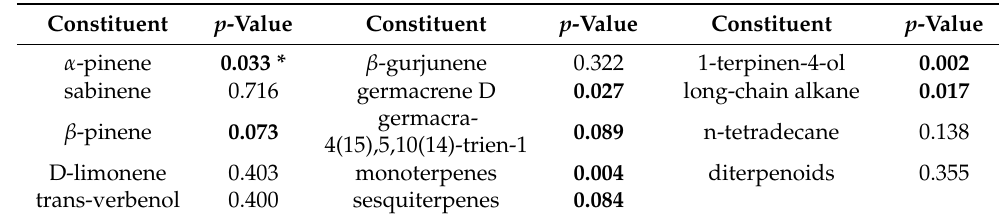
Table 2. ANOVA p -values showing the significance of the differences among the three collections in terms of H. arenarium concentrations.